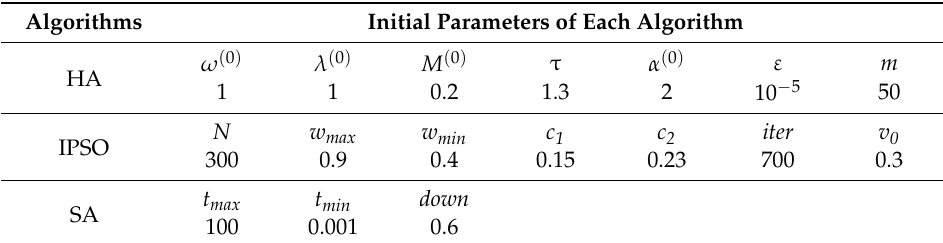
HA: Hybrid Algorithm; SA: Simulated Annealing